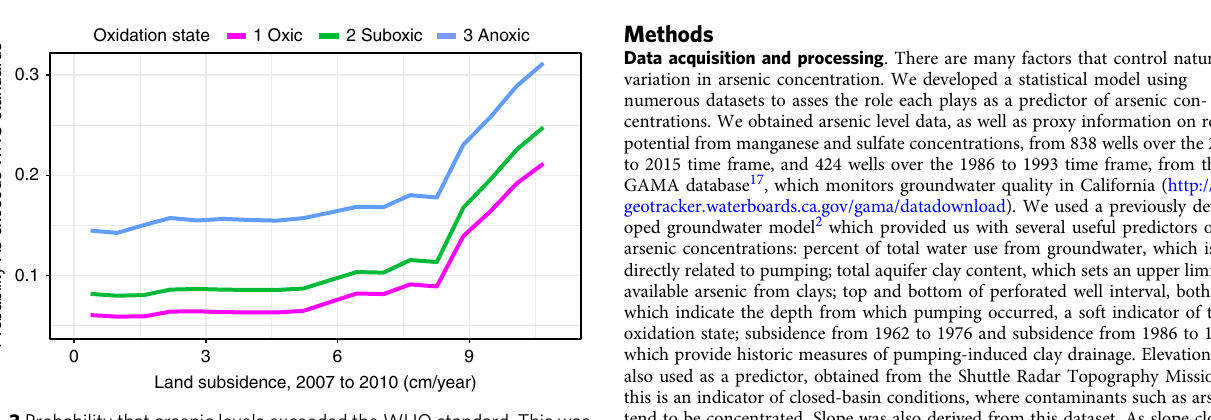
Fig. 2 Partial dependence plots of primary descriptors of groundwater arsenic concentrations. These include a con fi ning clay thickness, b dissolved Mn concentrations, c elevation, and d recent subsidence. e Comparison of partial dependence plots of historic and recent subsidence. Note that historic subsidence has a great effect on historic arsenic levels but little effect on recent arsenic levels ( e ), whereas recent subsidence has a great effect on recent arsenic levels ( d ). All blue lines are derived from models predicting recent (2007 – 2015) arsenic concentrations, whereas the red line is derived from models predicting historic (1986 – 1993) arsenic